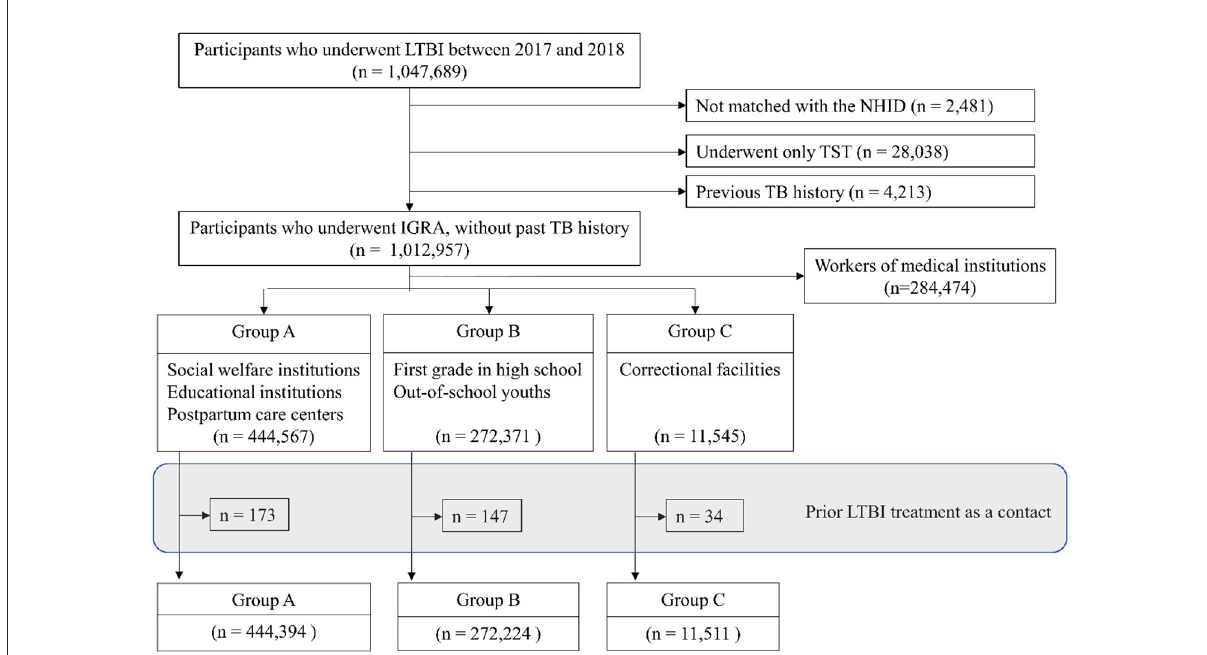
FIGURE1 Flow diagram. LTBI, latent tuberculosis infection; NHID, National Health Insurance Database; TST, tuberculin skin test; TB, tuberculosis; IGRA, interferon-gamma release assay. Group A: workers of postpartum care centers, social welfare facilities and educational institutions, Group